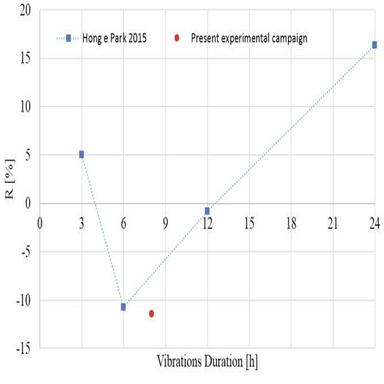
Comparison between percentage variation of compressive strength obtained from Hong and Park and from the present experimental campaign.